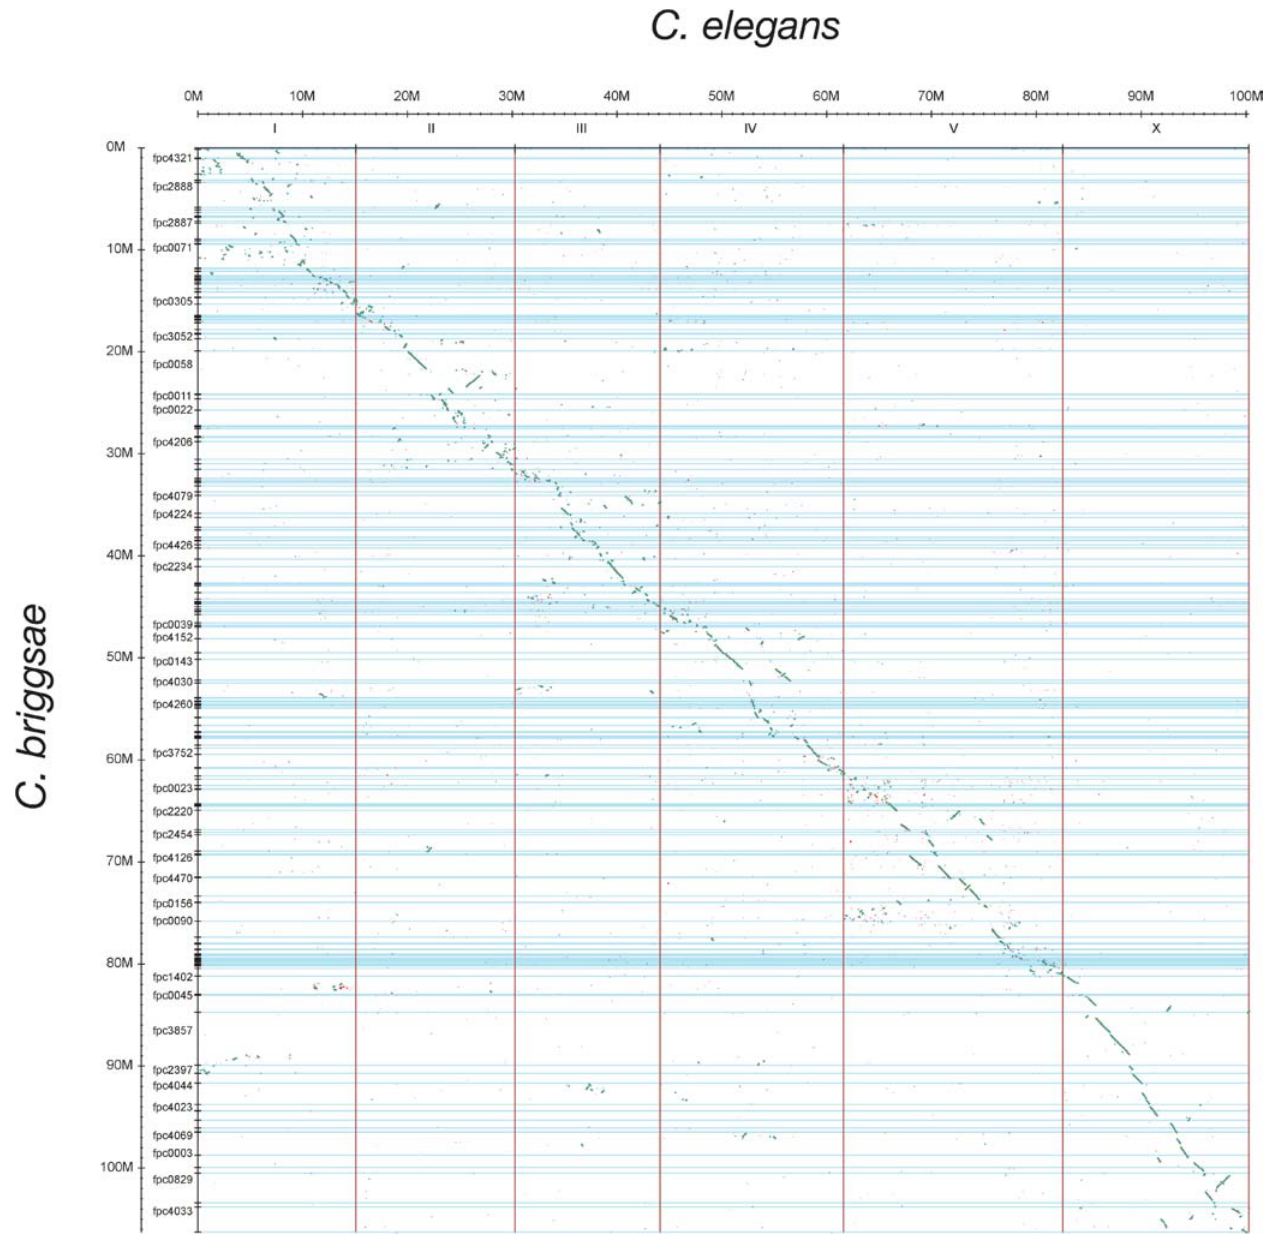
Figure 5. Representation of the C. briggsae WGS Assembly on a C. elegans Scaffold Using Colinearity Relationships C. briggsae supercontigs are shown on the y- axis, and C. elegans chromosomes from WS77 are shown on the x- axis. Red dots and lines indicate regions of colinearity identified by WABA alignments between the two genomes. Blue dots are the positions of protein orthologs. Green areas show where blue and red intersect, indicating concordance between the positions of ortholog pairs and colinearity blocks. DOI: 10.1371/journal.pbio.0000045.g005